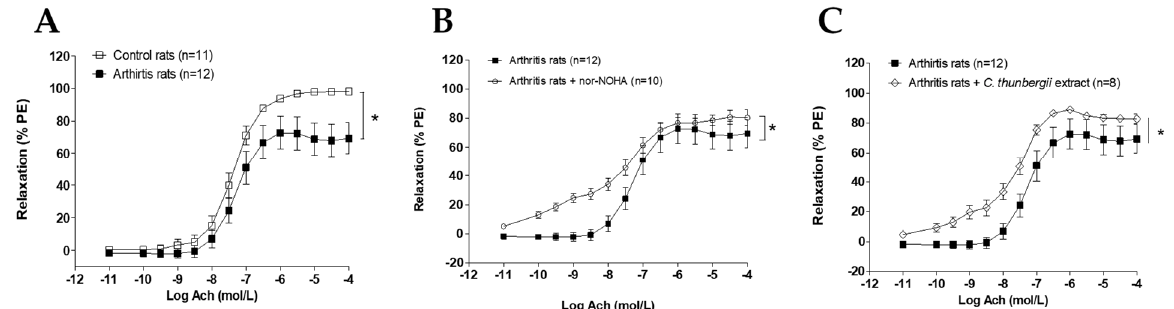
Figure 2. Acetylcholine (Ach)-induced relaxation in arthritic rats and the effect of Cyperus thunbergii extract. Experiments were performed on aortic rings from control and arthritis rats on day 33 post-immunization. Arteries were constricted with phenylephrine (10 − 6 mol/L) and relaxed with cumulative concentrations of Ach ( A ). The same experiments were performed in rings from arthritis rats in the presence of nor-NOHA (10 − 4 mol/L) ( B ) and Cyperus thunbergii extract (2.6 10 − 3 mg/mL) ( C ). Values are means ± standard error of mean (SEM) from n = number of aorta rings. * ( p < 0.05).